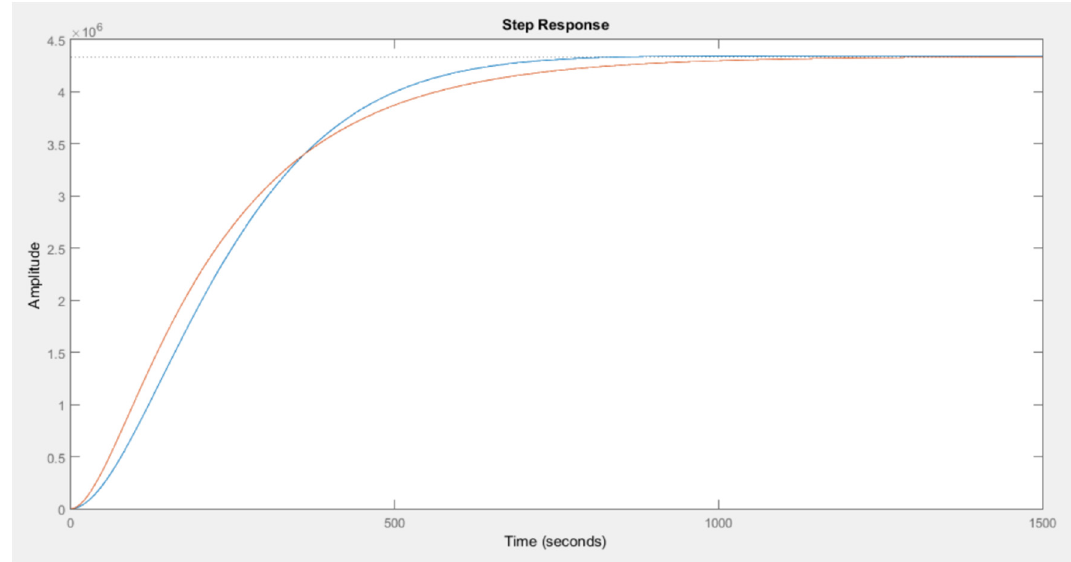
Figure 8. Length = 50 km, diameter = 1 m, mass flow = 120 kg/s.